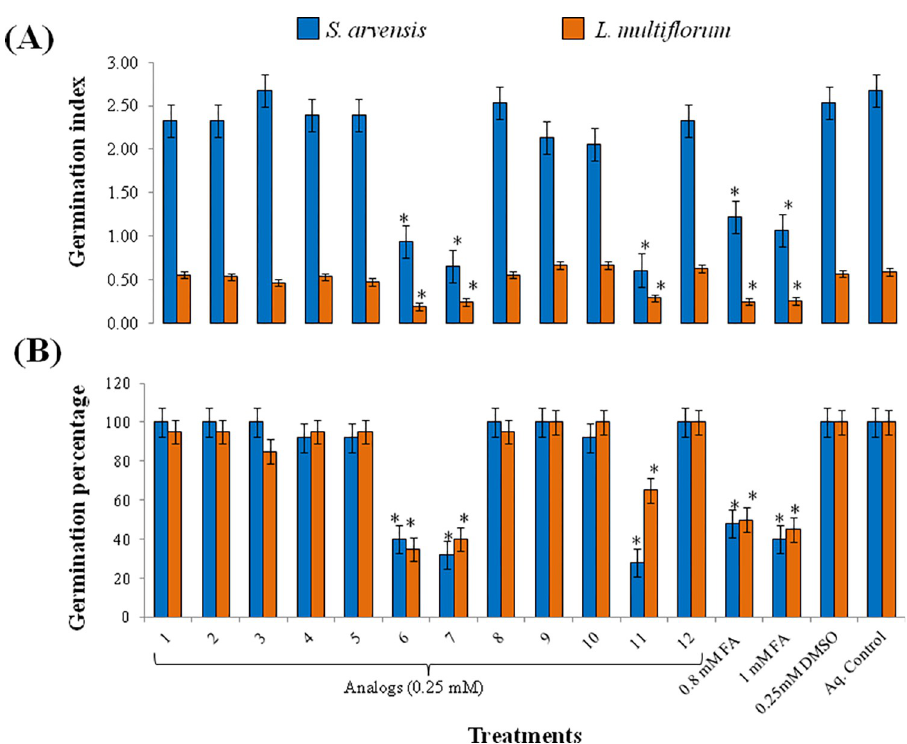
Fig 8. Effect of analogs on Sinapis arvensis and Lolium multiflorum in response to 0.25 mM analogs, 0.8 and 1 mM ferulic acid (FA) and aqueous control. (A) Germination index and (B) germination percentage. Analog 6, 7 and 11 had significant effect on GI and G% of both the weeds. Seed germination significantly reduced with FA at 0.8 and 1 mM concentration. Seeds grown with control treatments (0.25 mM DMSO and aqueous control) had no effect on germination. Data are presented as mean ± SE (n = 10). Bar values with asterisks differ significantly from solvent and aqueous control at P < 0.05.